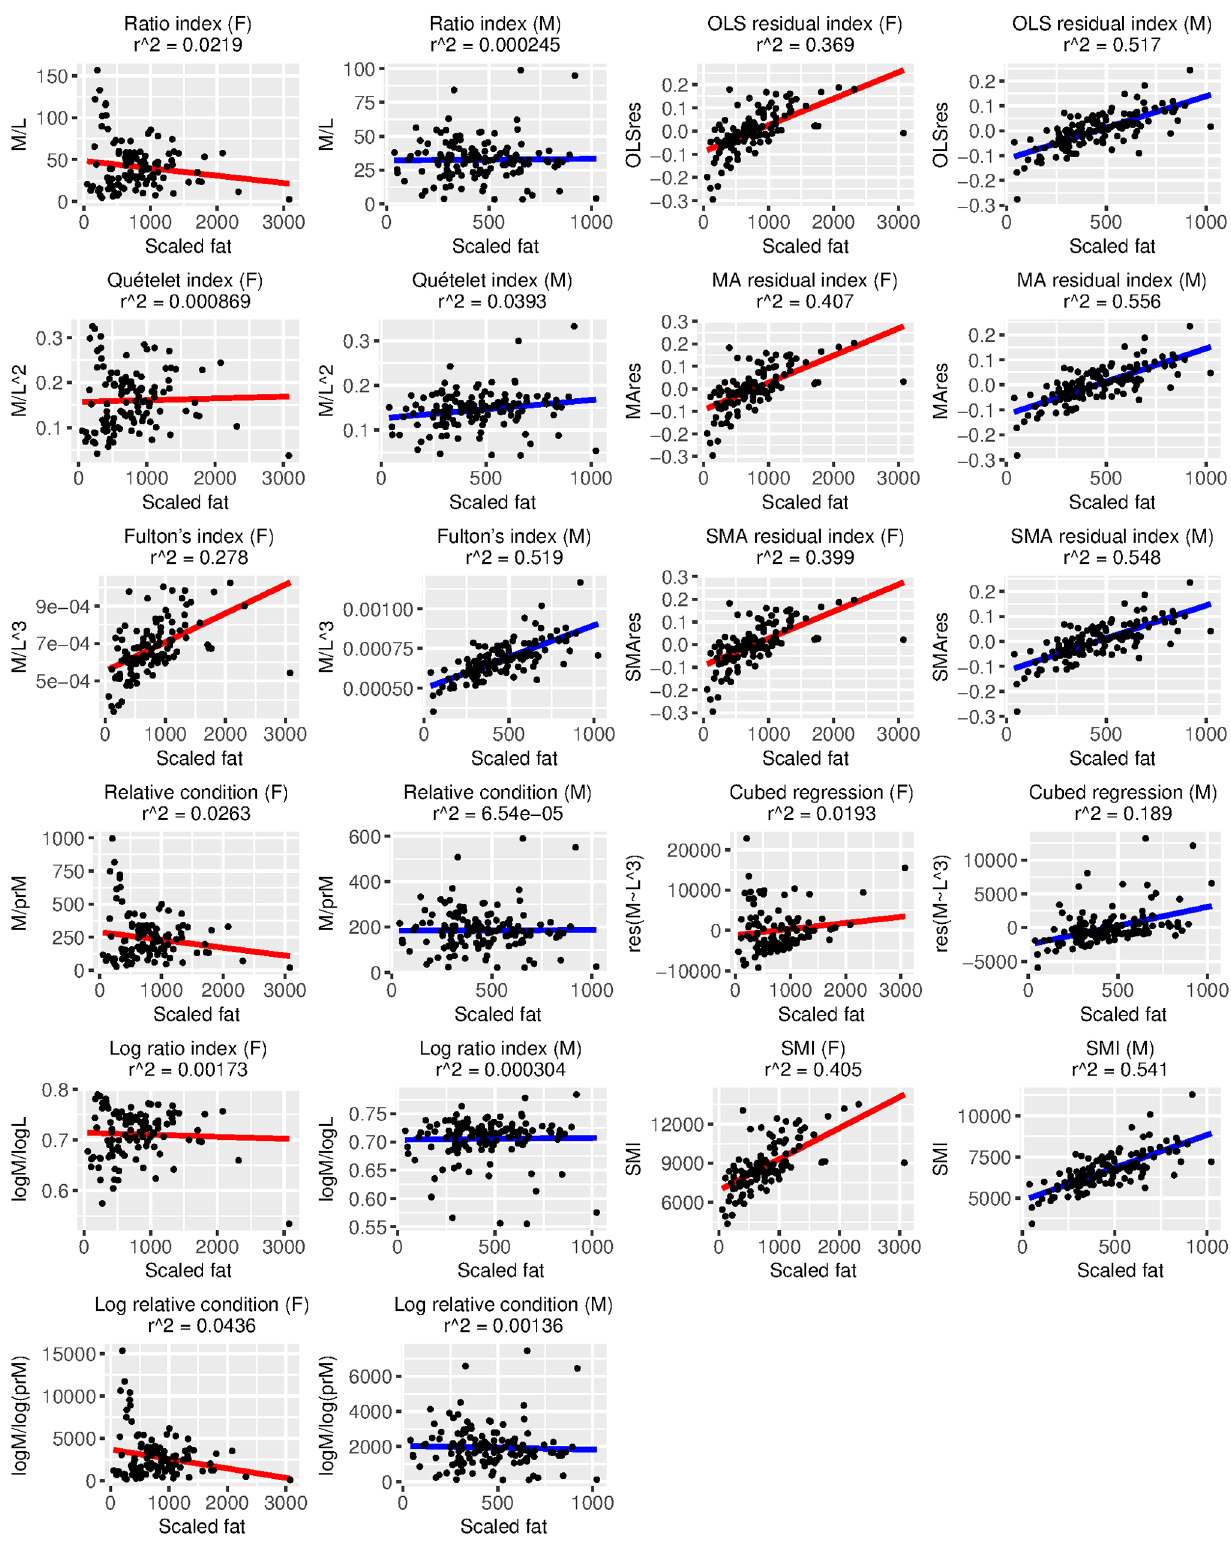
Fig 3. Relationships between 11 body condition indices (BCIs) and scaled fat, a measureof true body condition, for each sex. Variationin each BCI that can be explained by scaled fat is provided as an r 2 value. Ideally, most variation in a BCI shouldbe attributableto